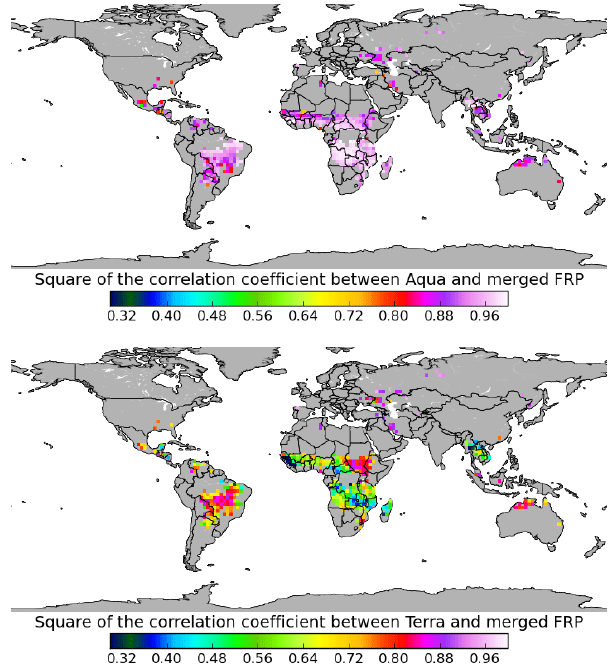
Figure 2. Square of the correlation coefficient between Aqua daily FRP (top), Terra daily FRP (bottom) and merged FRP. Fixed 2 ◦ × 2 ◦ regions were